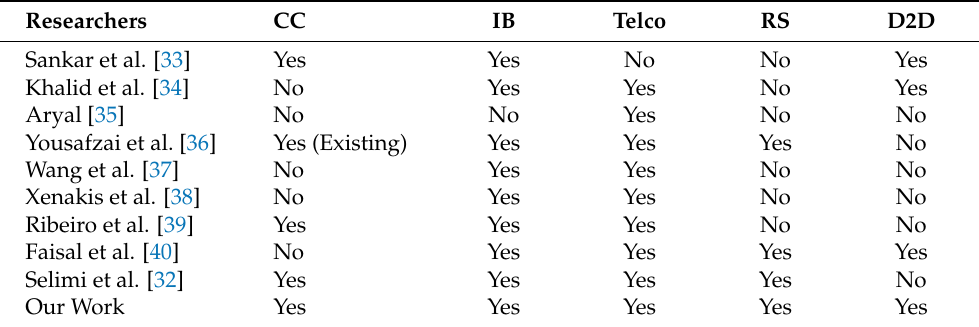
Table 1. Contemporary studies involving cryptocurrency-based system studies. CC: Crypto- Currency; IB: Incentive-based; Telco:Telecommunications Area; RS: Resource-sharing; D2D: Device- to-Device